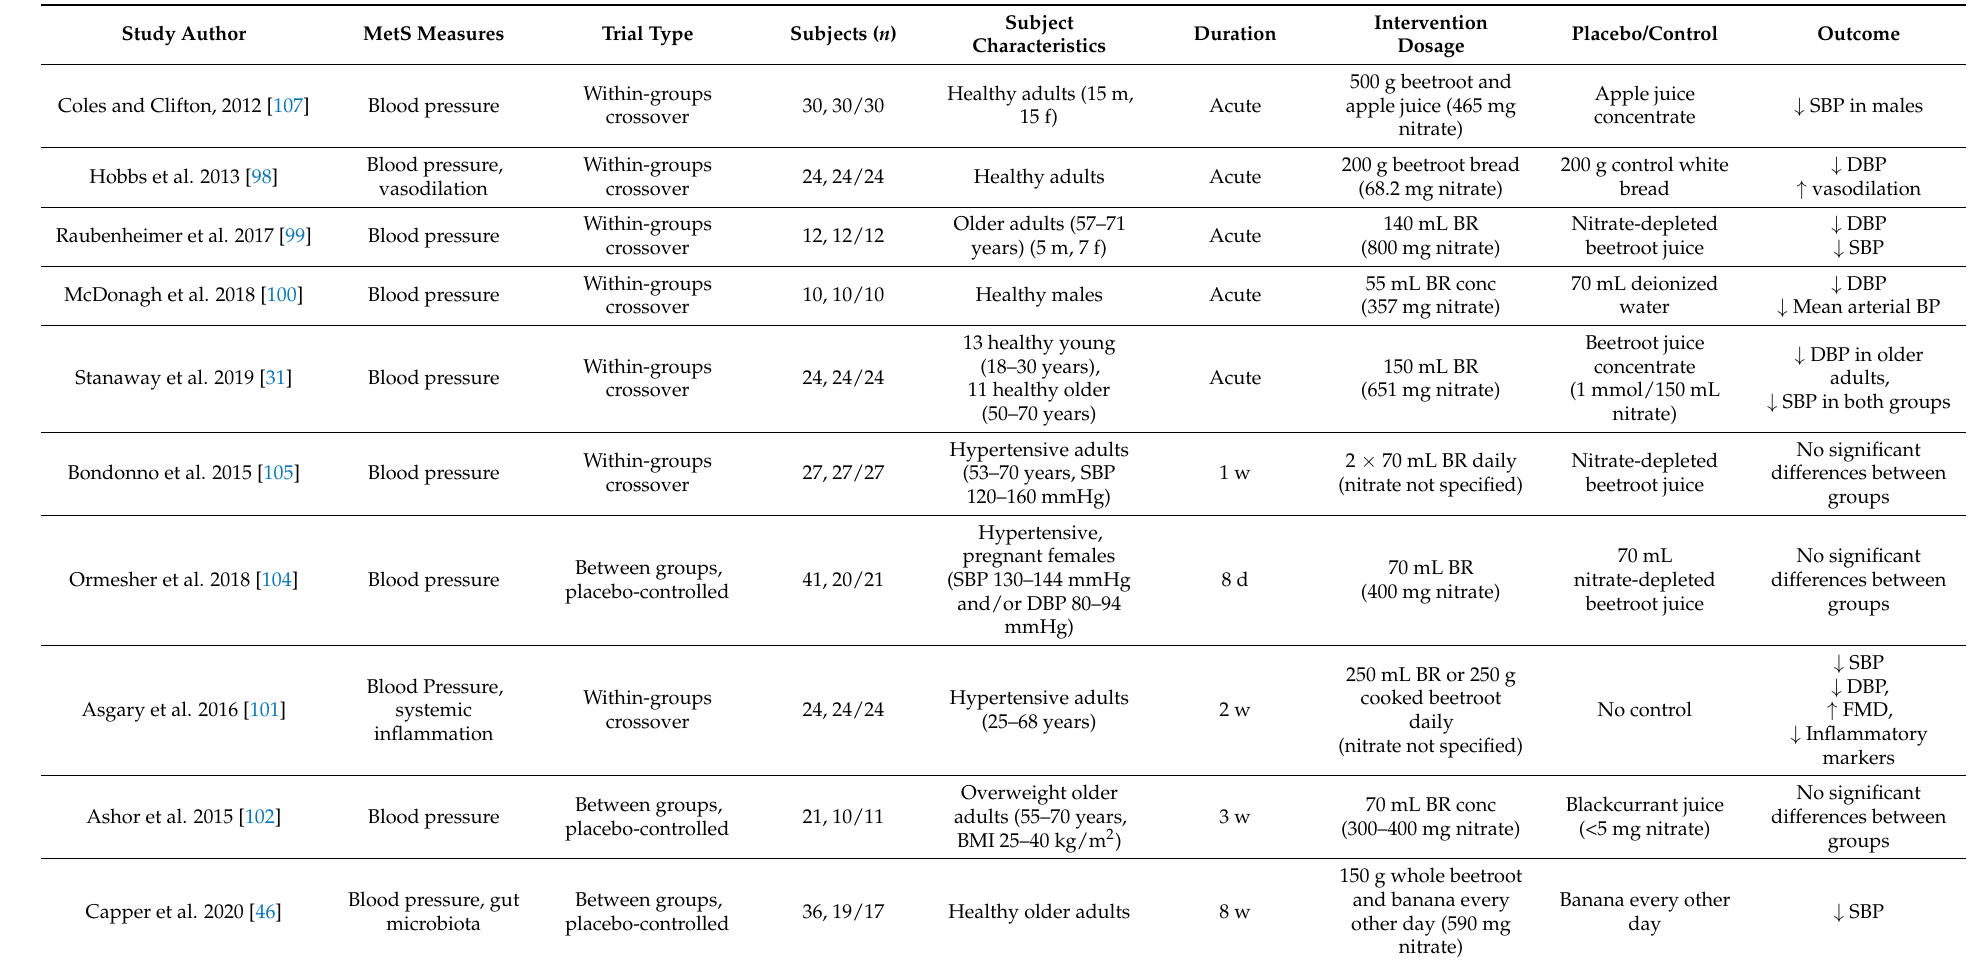
Table 4. Details of beetroot trials investigating